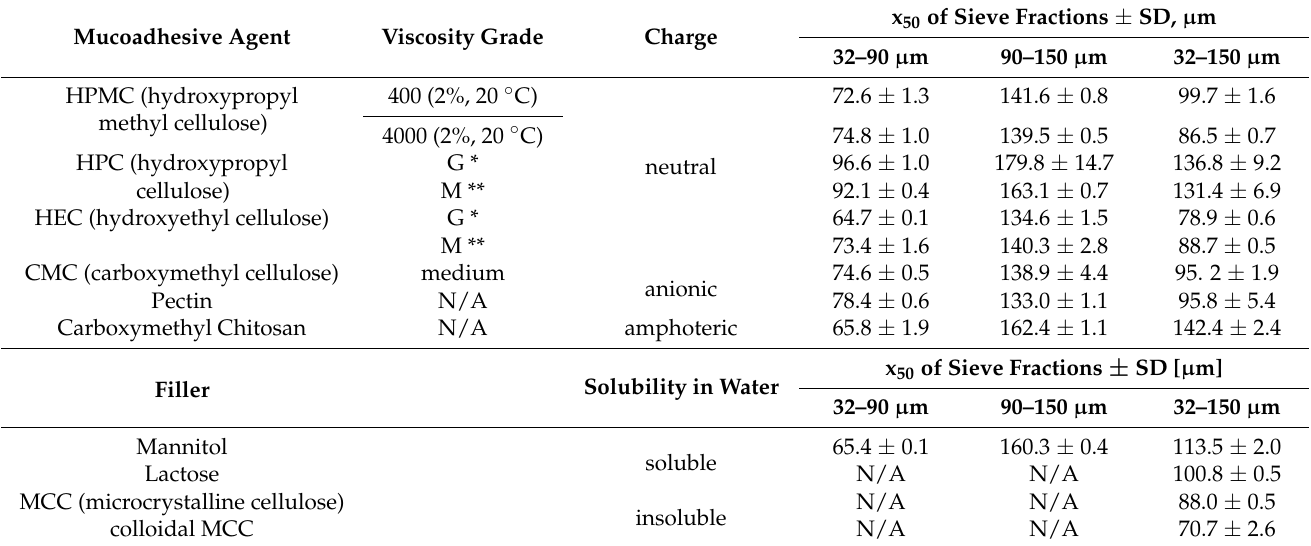
Table 1. Characteristics of the excipients selected for this